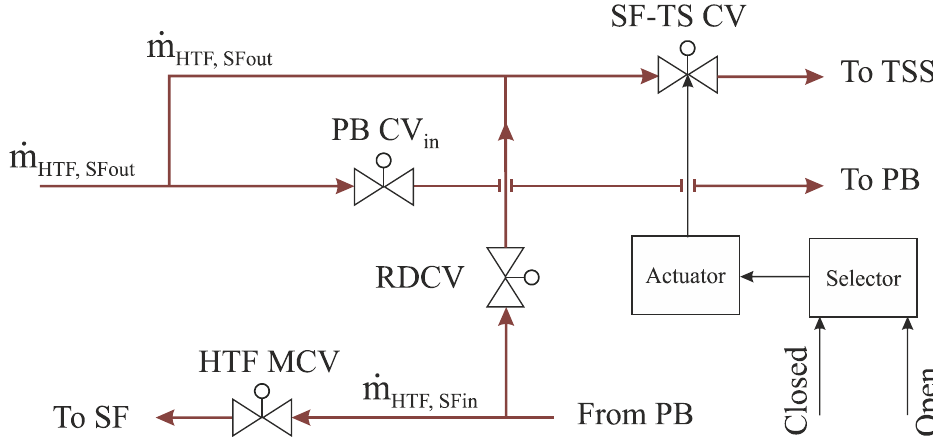
Figure 6. HTF control valve between the SF outlet and the TS inlet (simplified).